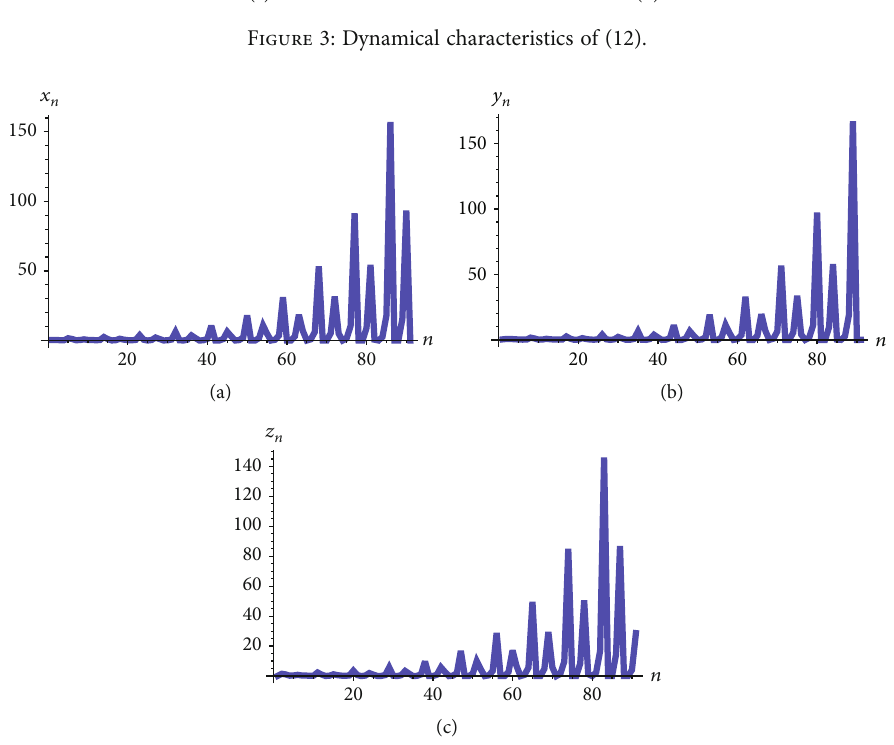
Figure 4: Dynamical characteristics of